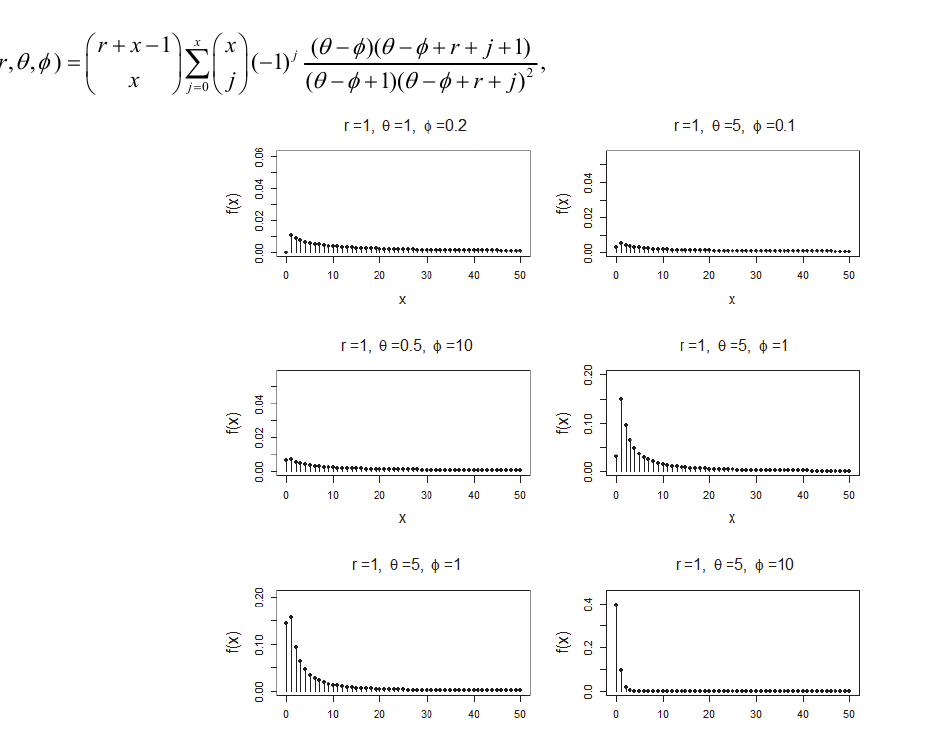
Fig. 2. The pmf of the NB-WL distribution of some specified values of , r  and